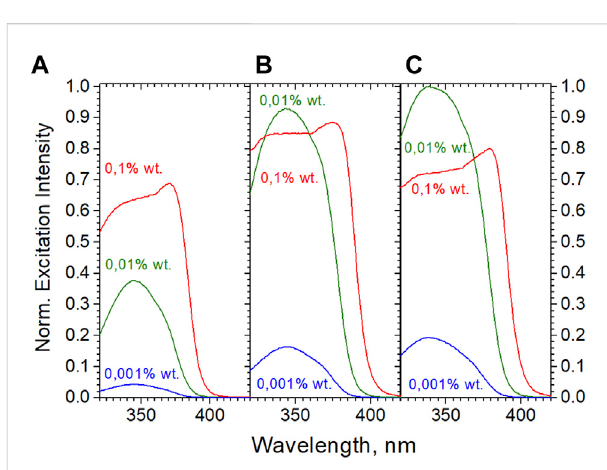
FIGURE 5 Excitation of 0.1, 0.01, and 0.001% wt aqueous bead dispersions. – beads ( fi nal content of complex in (A) : “ as made ” Eu(ttfa) 3 (TOPO) 2 beads 2.94% wt, diameter 150 nm). (B) : Eu(ttfa) 3 (TOPO) 2 – beads with shellfromstyrene-4-sulfonte(NaSS)andPMMA( “ method2 ” ,ESI; fi nal content of complex in beads 6.8% wt, diameter 223 nm). (C) Commercial Fluoro-Max — beads (201